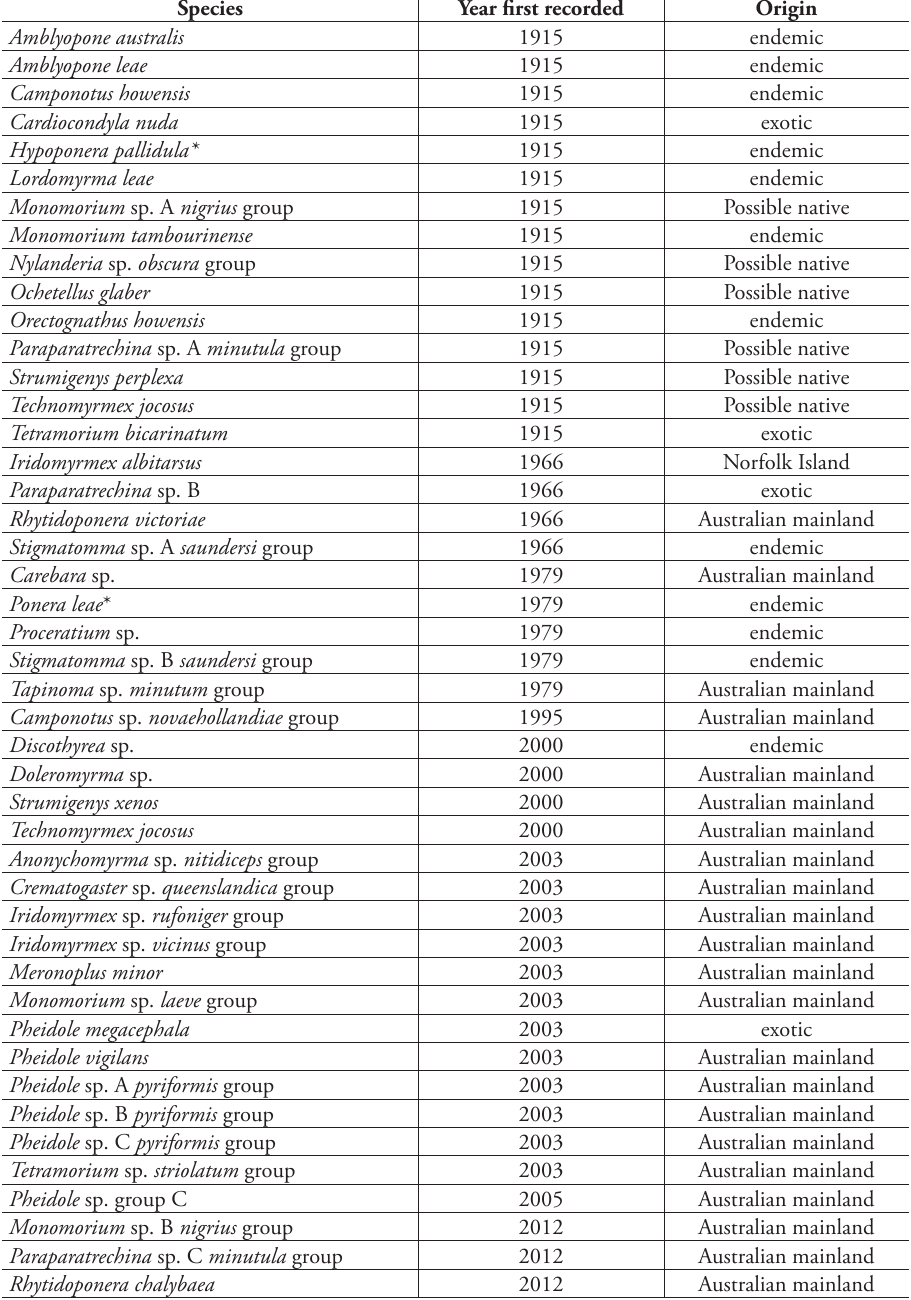
Table 1. Species list of the ants of Lord Howe Island with date of first record and biogeographic origin. * indicates species that the authors believe may have a taxonomic issue in that these species may instead be cryptic species native to Lord Howe